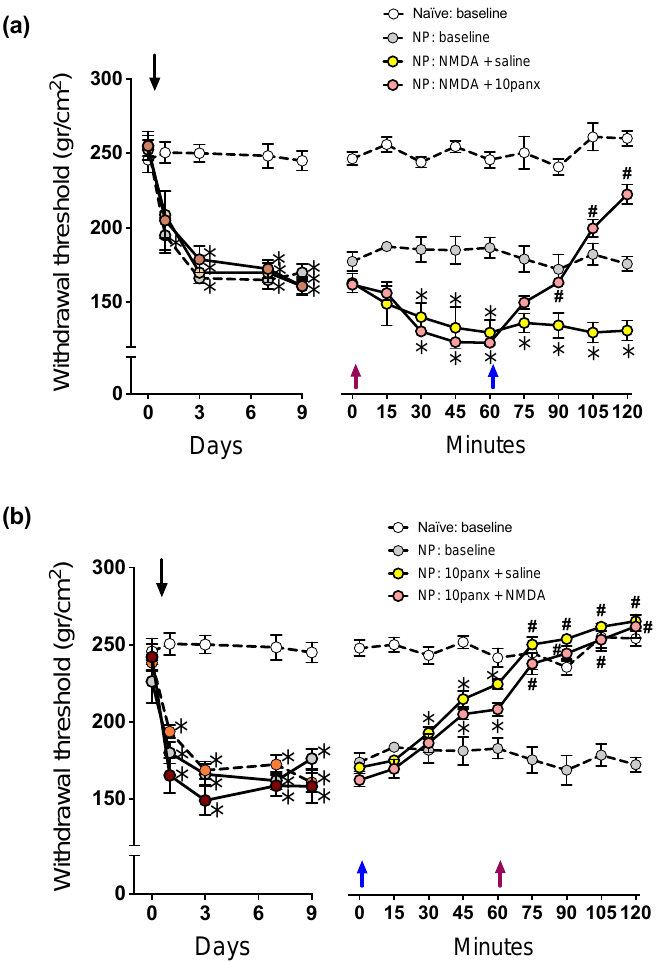
Figure 1. Effect of intrathecal administration of NMDA followed by 10panx, or 10panx followed by NMDA, on the mechanical nociceptive threshold (in g/cm 2 ) of neuropathic (NP) rats. Naïve (baseline) and NP (baseline) rats without receiving any drug served as controls. Values are means ± SEM, n = 6 rats in each group. ( a ) Left panel: Time course of development of NP after sural nerve cutting, performed on day zero (downward arrow), during a 9-day period of follow-up. Two-way